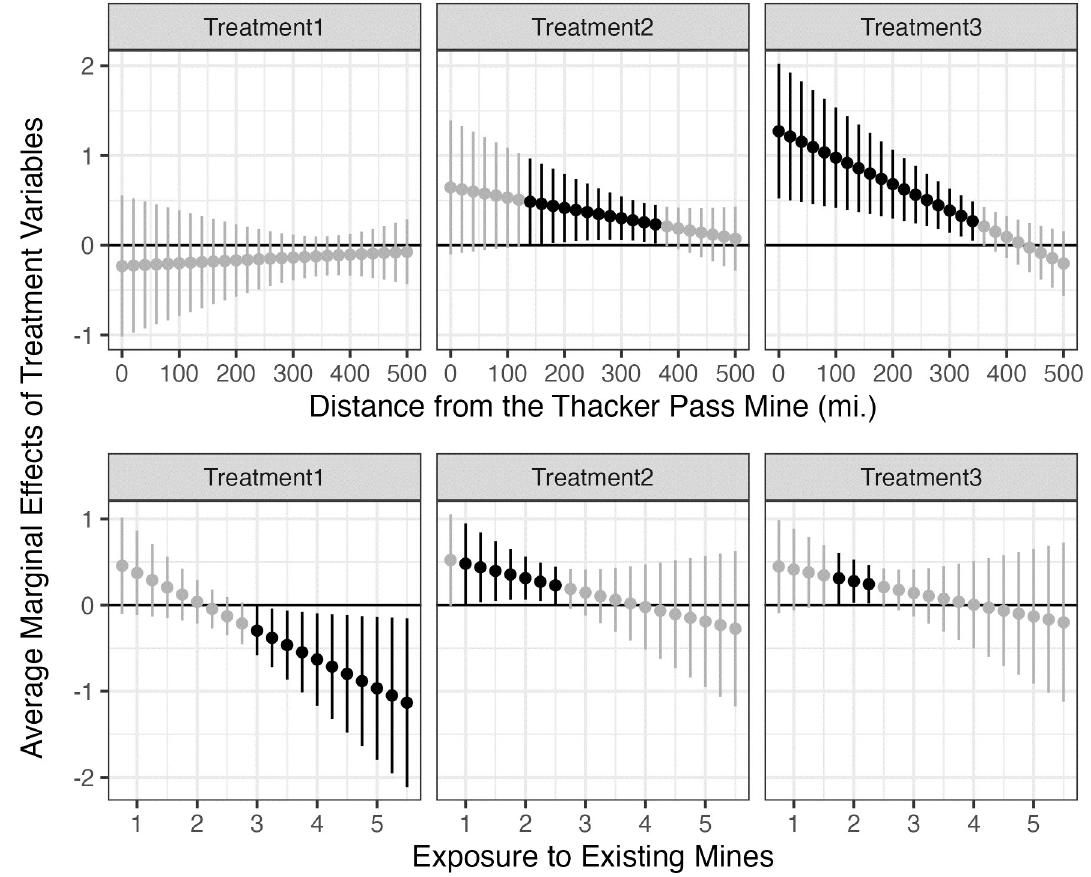
Fig 4. Conditional effect of treatment on dist_TP and exposure